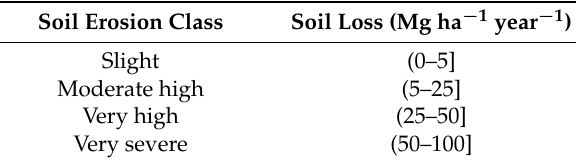
Table 2. Priority scales for soil